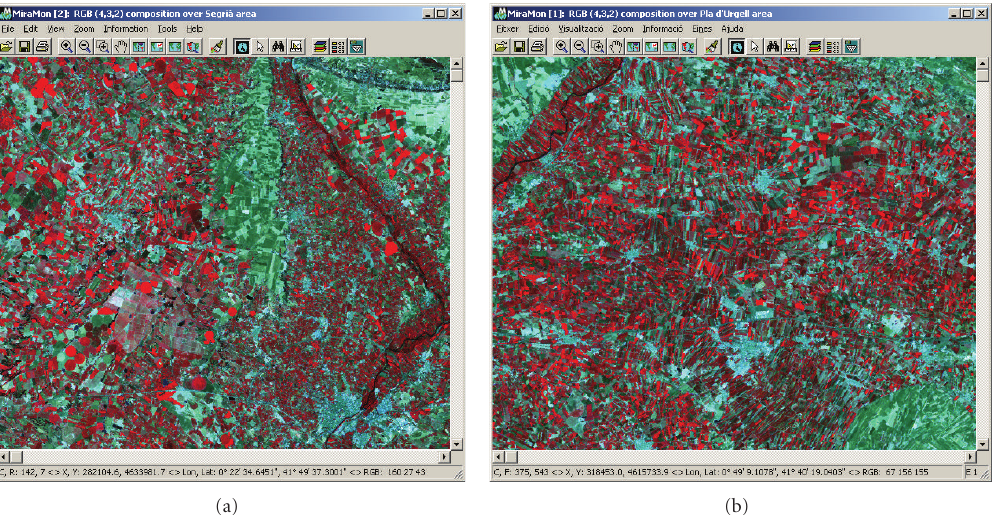
Figure 3: False color RGB composition (NIR, red and green bands of the 17th of June scene) of both studied areas: Segri`a (a) and Pla d’Urgell